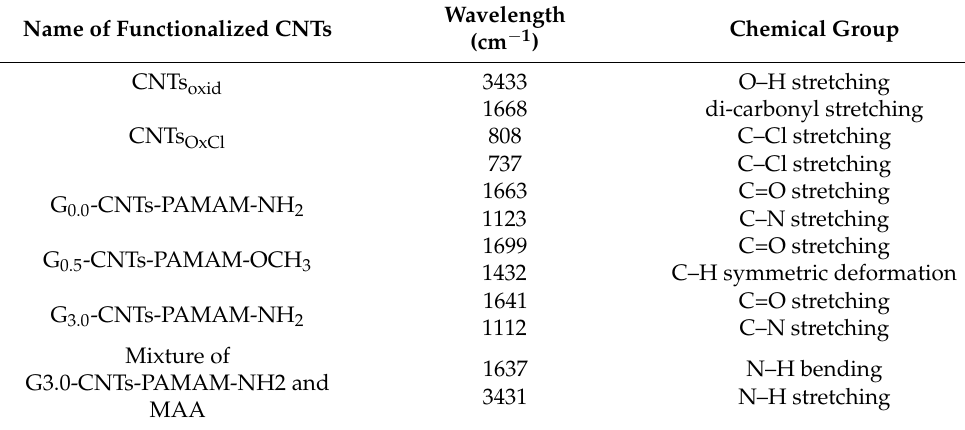
Table 2. Wavelengths of the representative bands and chemical group that cause them for each type of functionalized CNTs whose chemical structure was presented in the Scheme